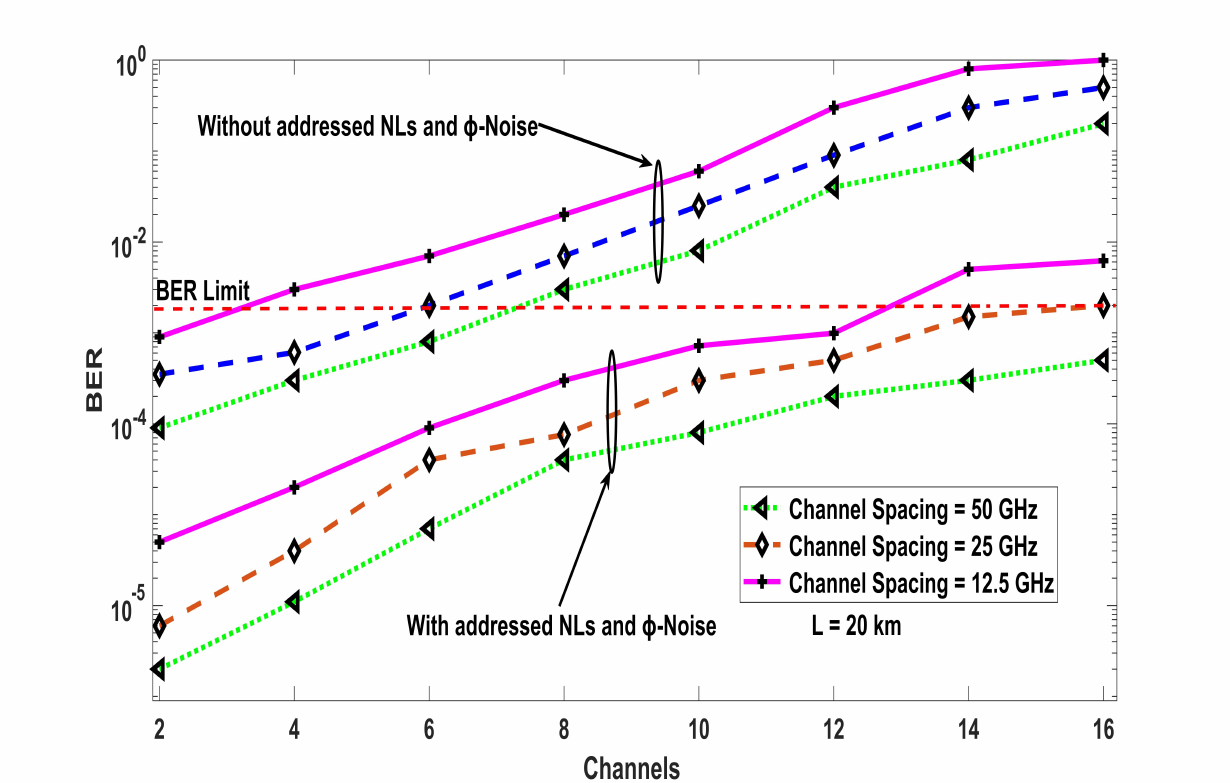
Figure 6. Comparison of various types of channel spacing and fiber length in terms of BER and the quantity of channels.